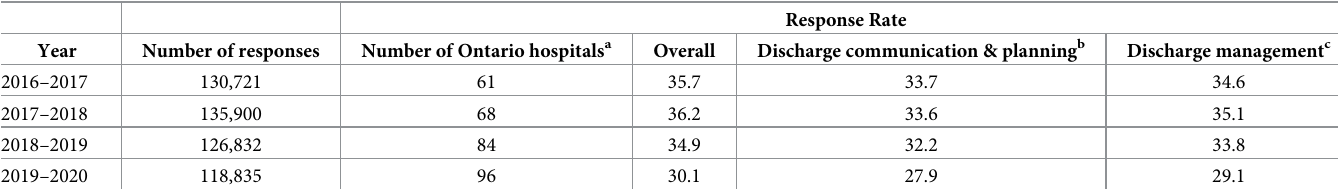
Table 2. Ontario CPES-IC response rates—overall and measures (discharge communication & planning and discharge management) by fiscal